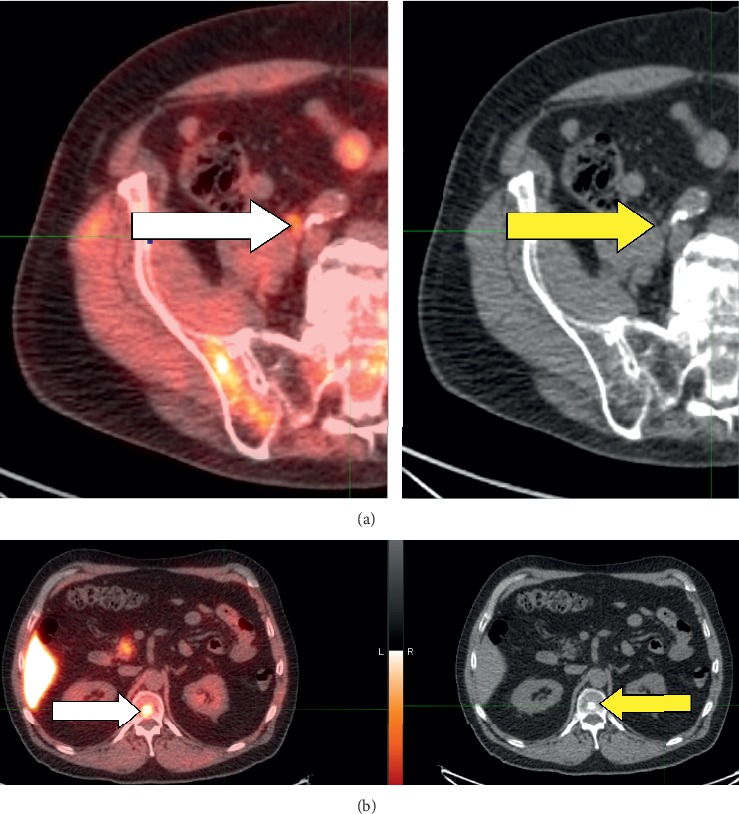
Images of an 80-year-old male who had received robotic-assisted laparoscopic prostatectomy and salvage radiation therapy. He was referred for 18F-fluciclovine imaging with PSA rising to 1.1 ng/mL. Top row: The axial, fused PET/CT image on the left identifies a focus of mildly enhanced 18F-fluciclovine uptake (white arrow) at the level of the common iliac vessels. The corresponding CT image on the right identifies 2 small, 5-mm lymph nodes (yellow arrow). Bottom row: note the 18F-fluciclovine-avid lesion in the body of T12 (white arrow, left-hand image), with the corresponding CT view on the right demonstrating the lesion at the identical location (yellow arrow).